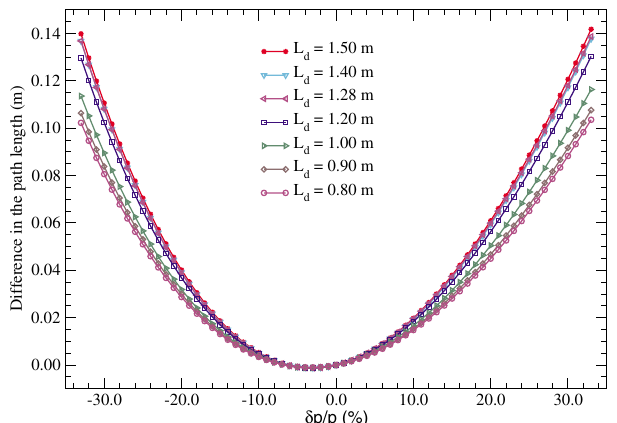
FIG. 11. (Color) Difference in the path length during accelera- (cid:1) 328 m at tion. Each lattice has a fixed circumference of C 0 central energy; the length of the major combined function (cid:1) 0 : 8 – 1 : 5 m magnet varies from L d